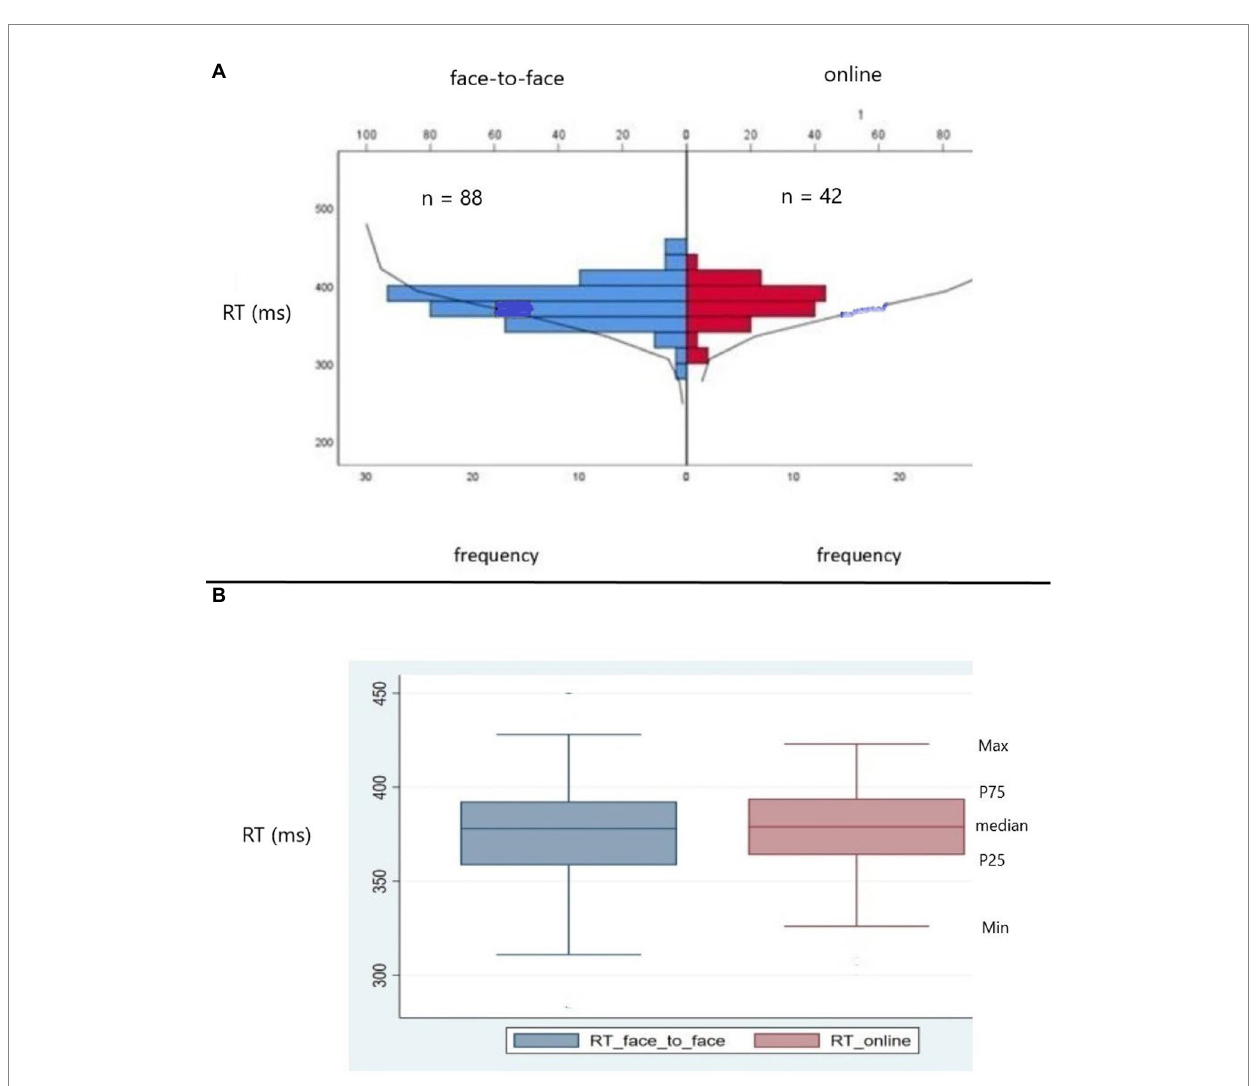
FIGURE 2 (A) Kolmogorov–Smirnov test (KS) for independent samples for correct reaction time (RT) comparing the distributions of data from American participants tested online and face-to-face In red RT data from participants exposed to online test; in blue, RT data from participants exposed to face- to-face test. The frequency distributions of RT for the two modalities did not differ (KS = 0.48, p > 0.70, two sides, ns). ns = non-significant. (B) Box plots showing median, percentile 25th (P25), percentile 75th (P75), minimum, and maximum RT values. In red, RT data from participants exposed to online test. In blue, RT data from participants exposed to face-to-face test. Observe that the frequency distributions for both modalities are